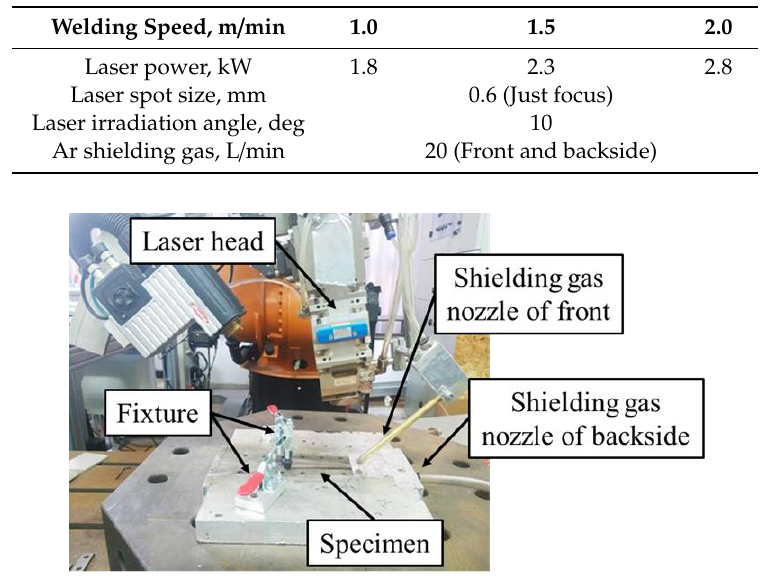
Table 2. Laser welding conditions.